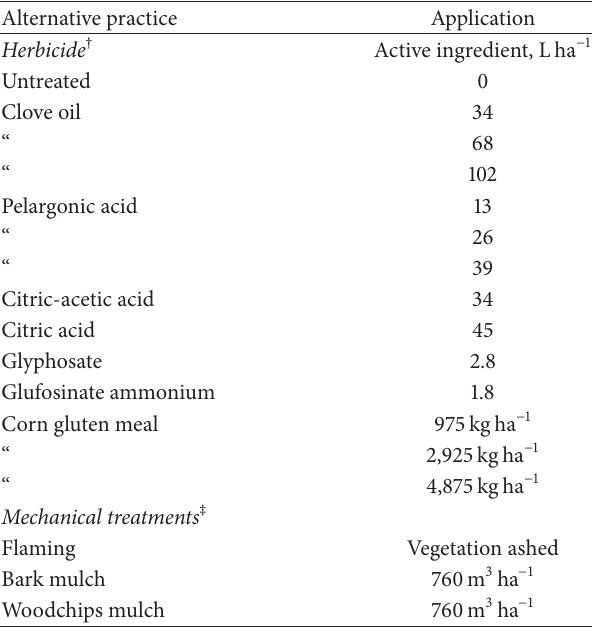
Table 1: Treatments in experiments involving alternative herbicides applied in differing amounts, conventional herbicides, and mechan- ical treatments in field plot research (Field Experiment 1).